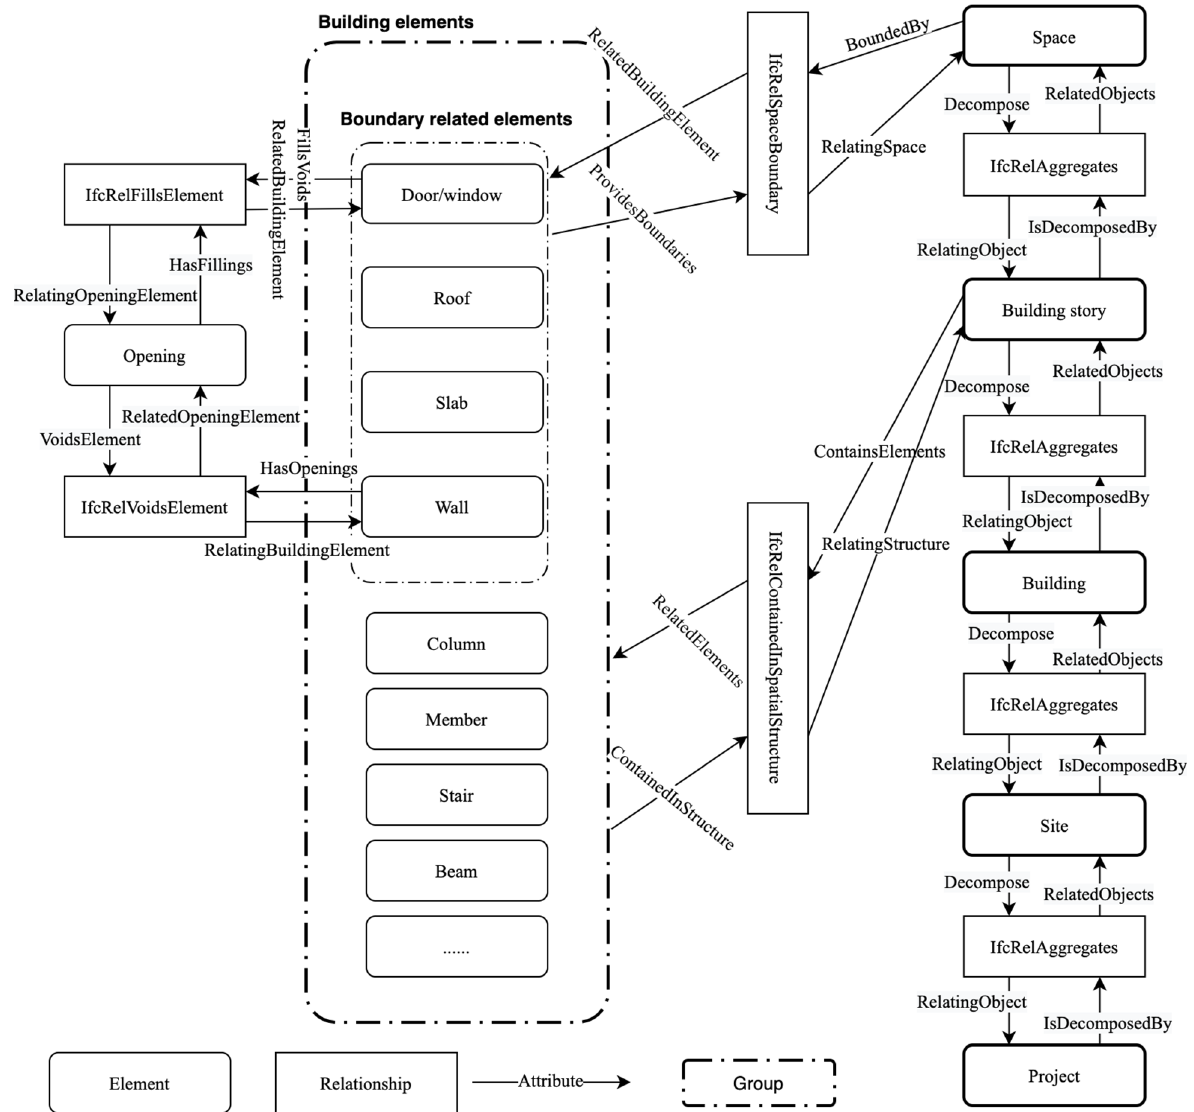
Figure 2. A typical spatial structure of IFC data.